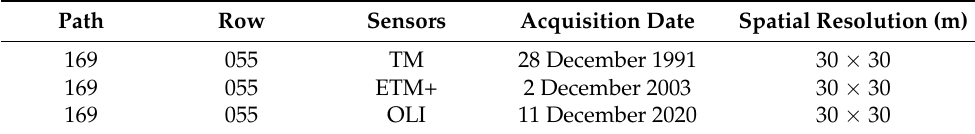
Table 1. Landsat image characteristics used for LULC change. Path Row Sensors